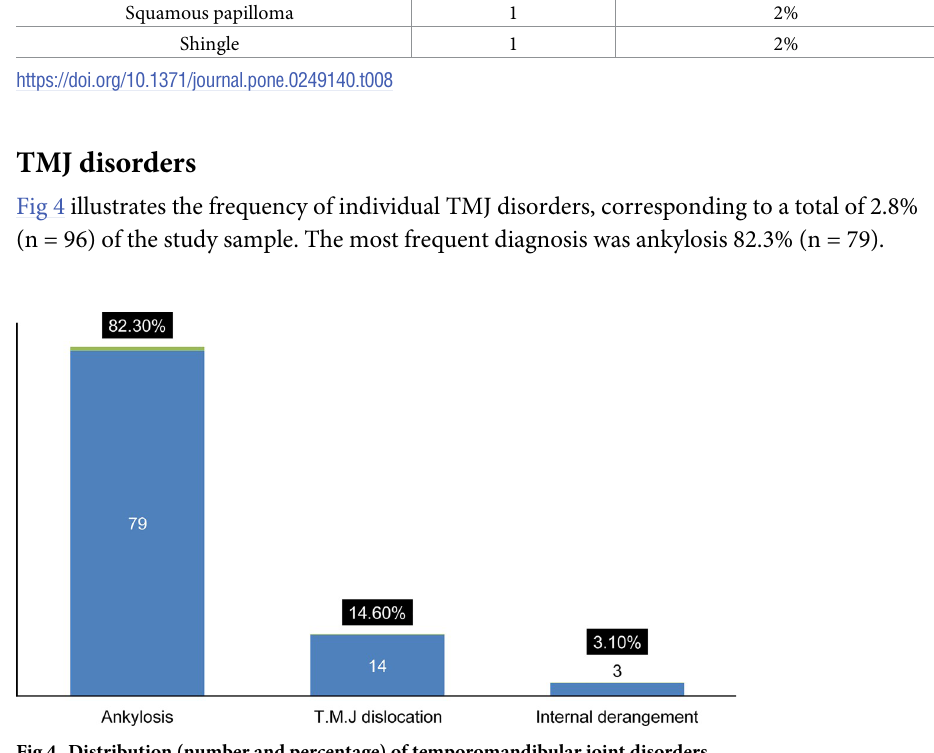
Fig 4. Distribution (number and percentage) of temporomandibular joint